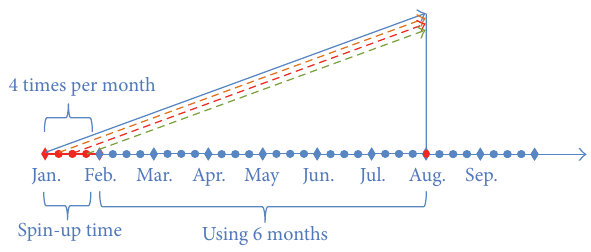
Figure 2: Prediction procedure, exemplarily shown for model initialization in